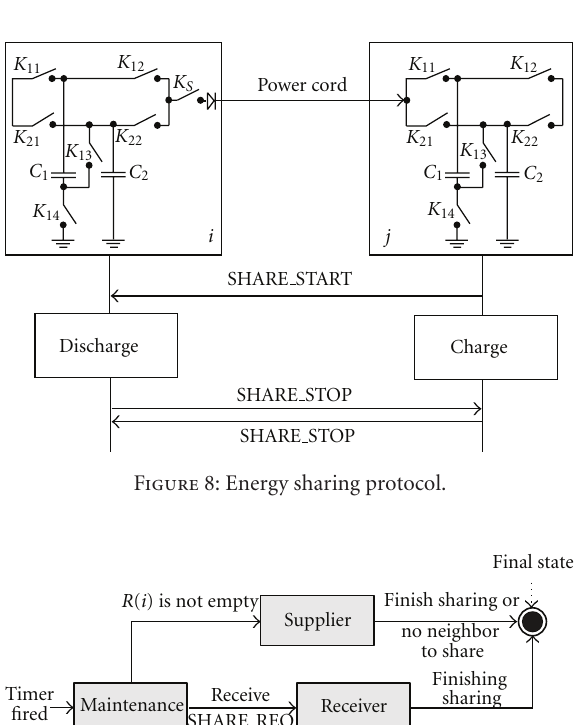
Figure 9: State machine diagram of network